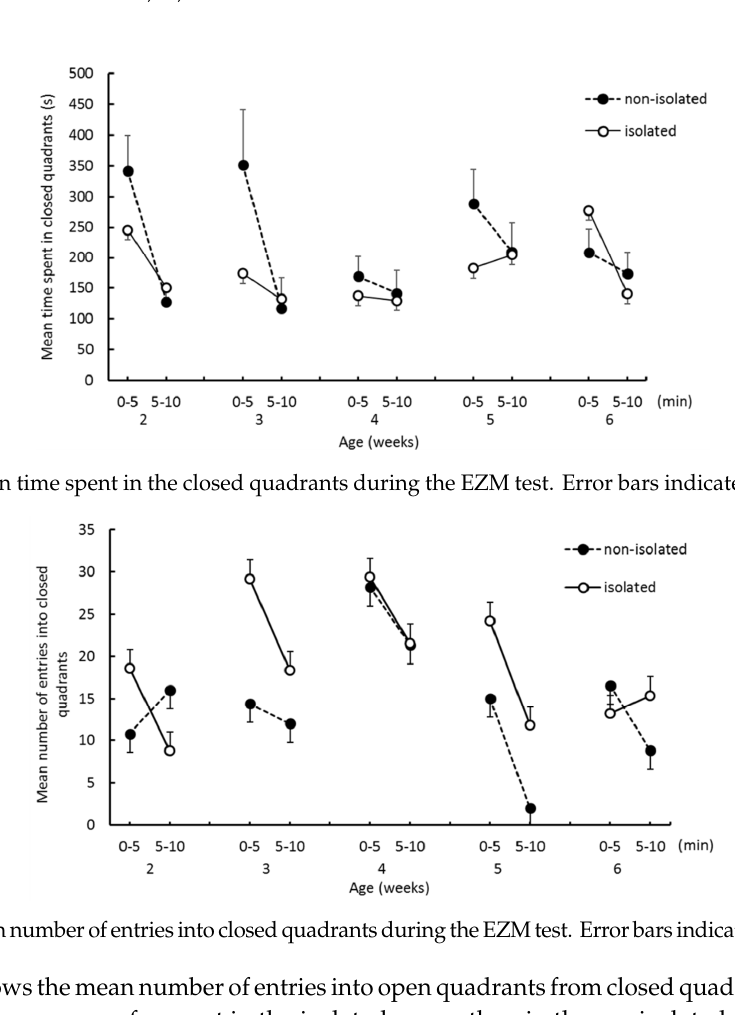
Figure 4. ThemeannumberofentriesintoclosedquadrantsduringtheEZMtest. Errorbarsindicatethestandarderror. Figure 4. The mean number of entries into closed quadrants during the EZM test. Error bars indicate the standard error.